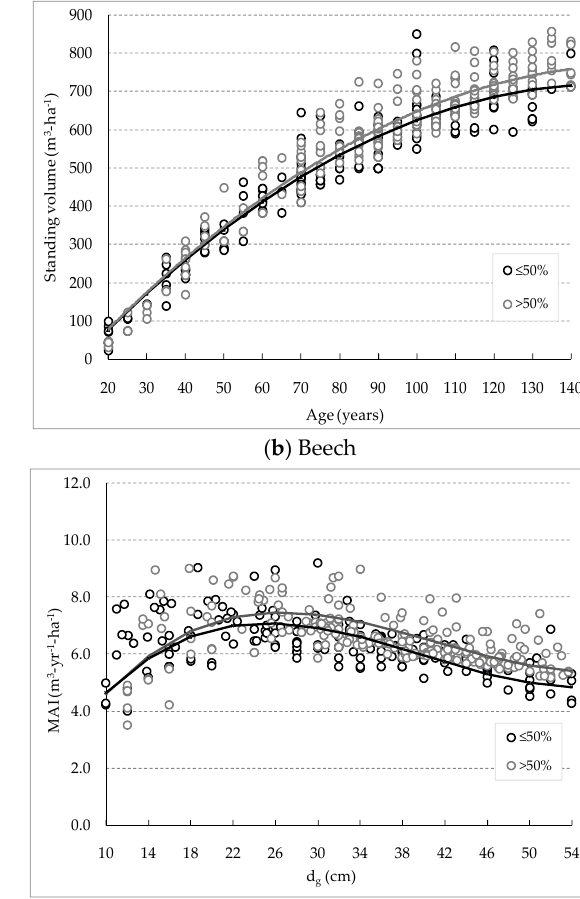
Table 6. Maximum